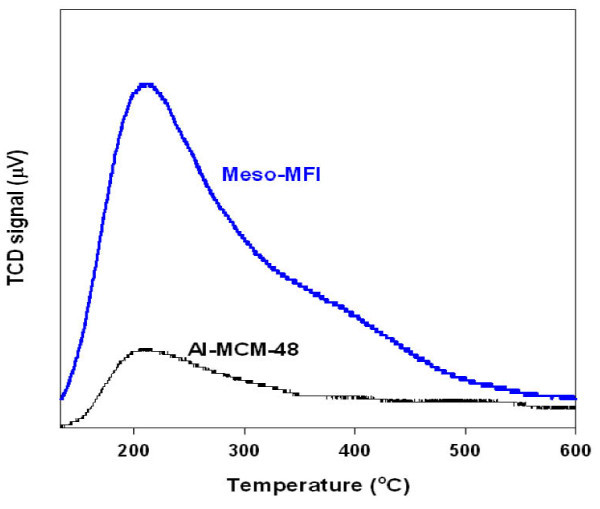
NH3 TPD of Meso-MFI and Al-MCM-48.